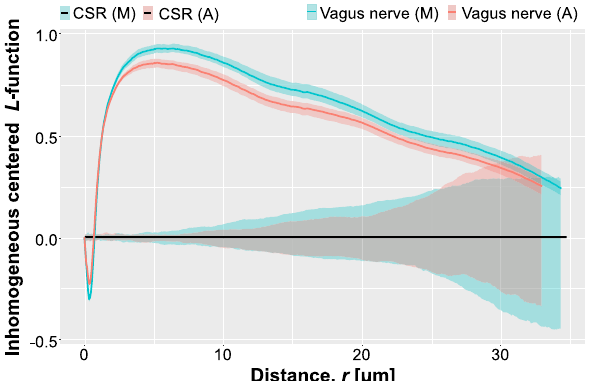
Figure 8. Plot of empirical L -functions computed for manually, and automatically segmented vagus nerve image. CSR—complete spatial randomness, A—automated segmentation, M—manual segmentation. Shaded areas shows the boundaries of 95-percentile confidence interval.